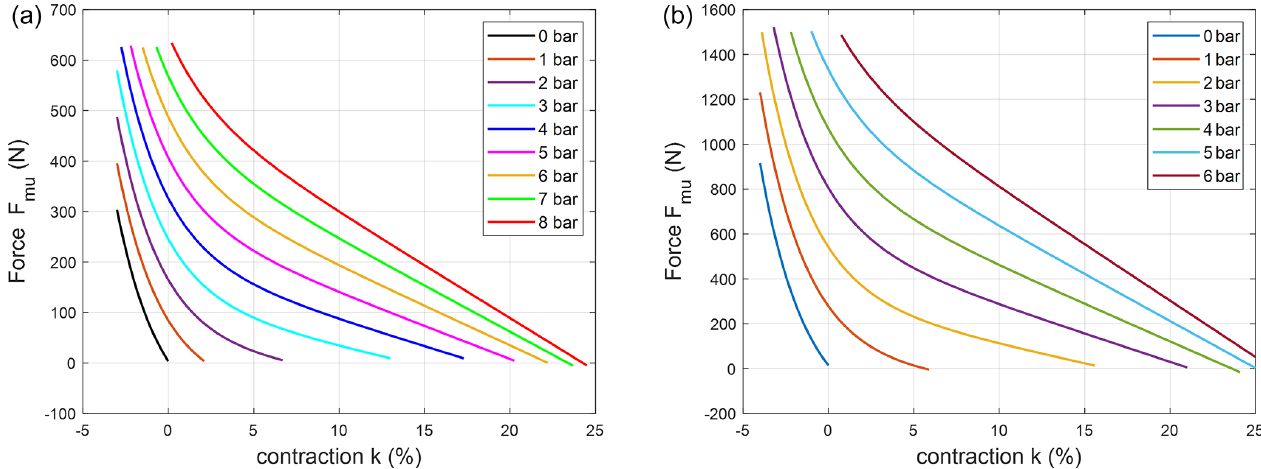
Figure 2. Static characteristics of McKibben muscles: DMSP-10-100N series (a) and DMSP-20-200N series (b) from FESTO at different supply